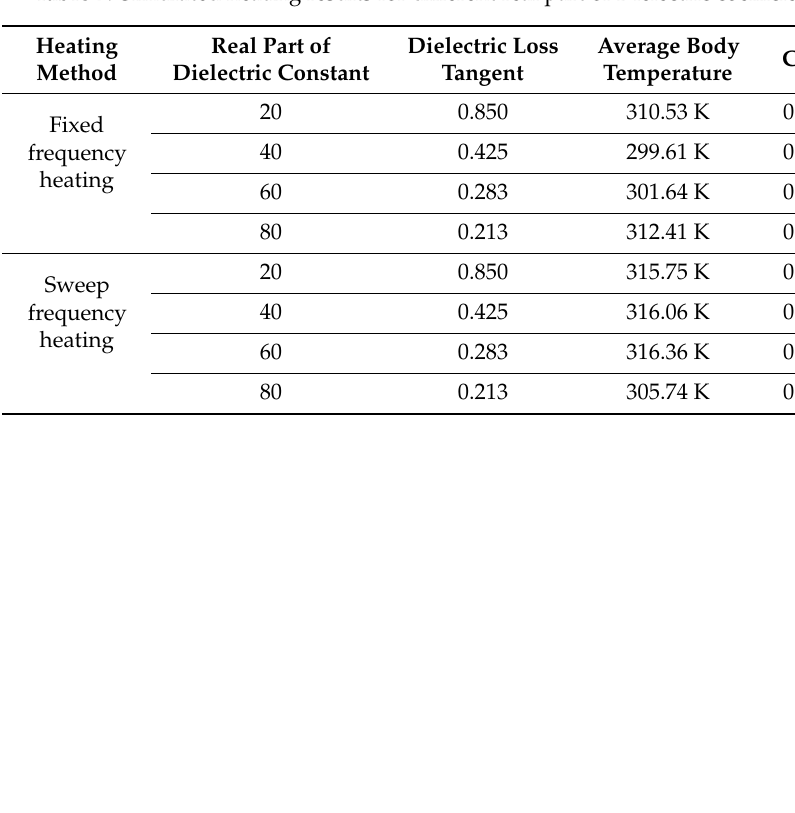
Table 7. Simulated heating results for di ff erent real part of Dielectric coe ffi